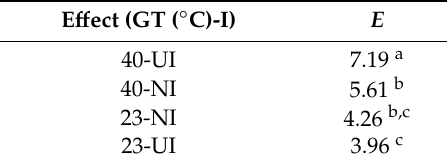
Table 7. E ff ect of di ff erent greenhouse temperatures (GT, ◦ C) and irrigation (UI) or no irrigation